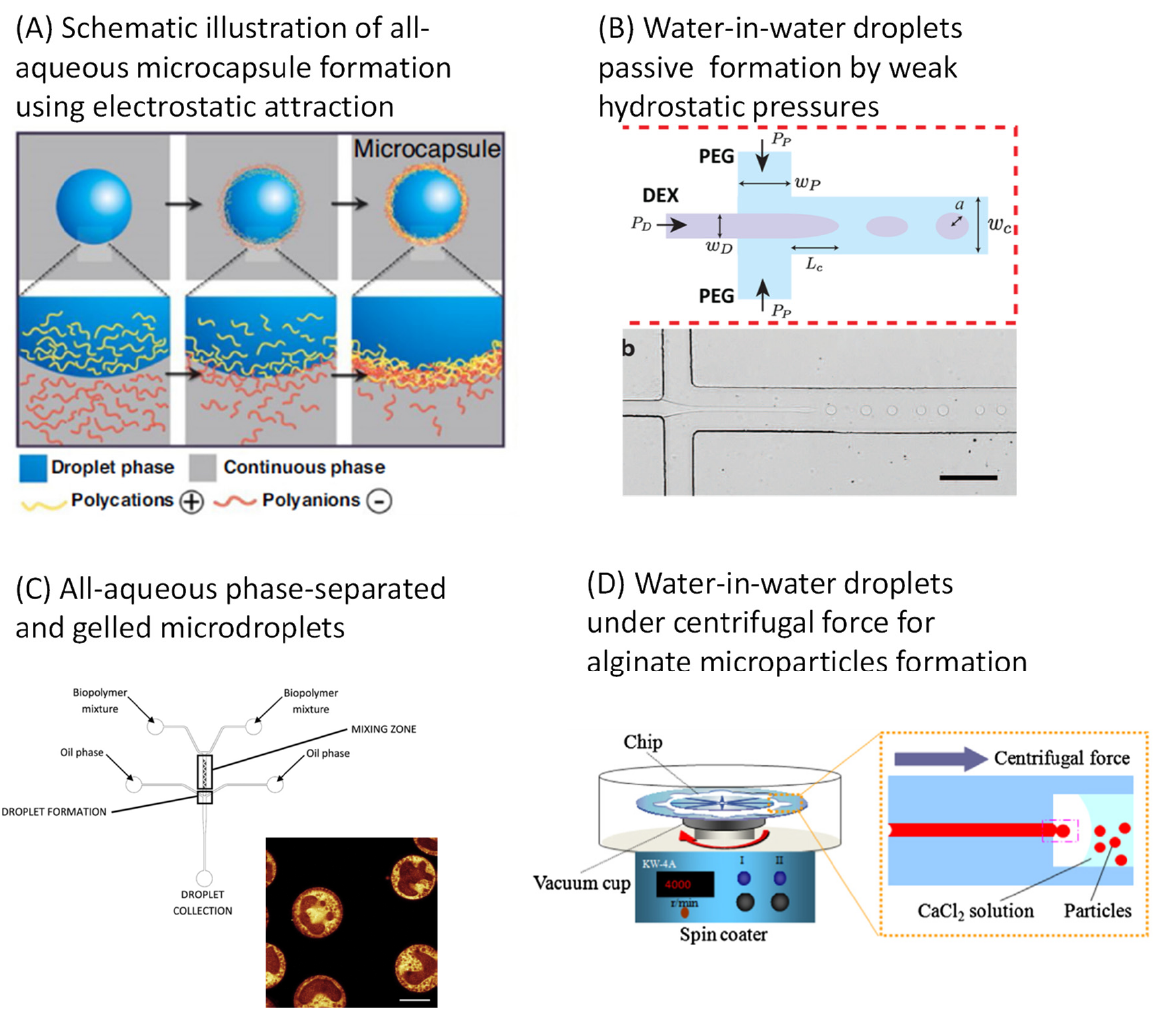
Figure 6. Schematic principles of all-aqueous microcapsule formation. ( A ) Reprinted from [60], under the terms of the Creative Commons Attribution 4.0 International license. ( B ) Adapted with permission from [66]. Copyright (2016) American Chemical Society. ( C ) Reprinted from [63], with permission from Elsevier. ( D ) Reprinted from [65], with permission from Elsevier.